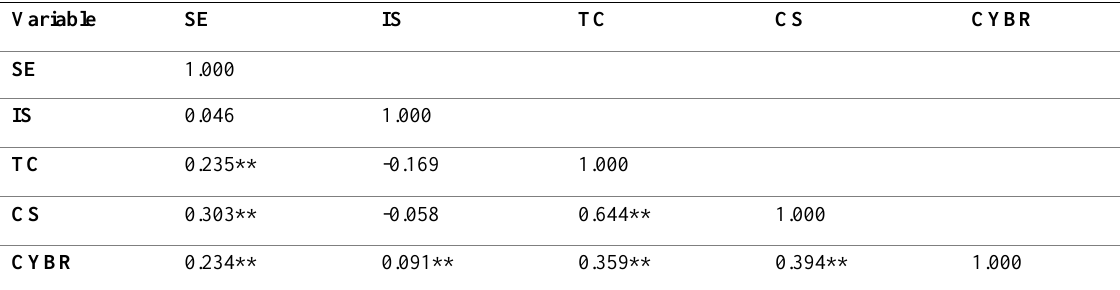
Table 3: Matrix of the correlation coefficient between research